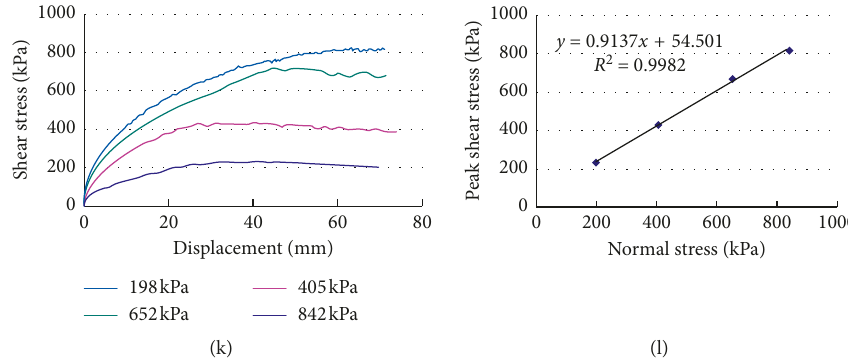
Figure 5: The relationship curve representing test results for sample waste rocks. (a) Shear stress-displacement curve for Pit J1 (natural). (b) Peak shear stress-normal stress curve for Pit J1 (natural). (c) Shear stress-displacement curve for Pit J1 (saturated). (d) Peak shear stress- normal stress curve for Pit J1 (saturated). (e) Shear stress-displacement curve for Pit J2 (natural). (f) Peak shear stress-normal stress curve for Pit J2 (natural). (g) Shear stress-displacement curve for Pit N2 (natural). (h) Peak shear stress-normal stress curve for Pit N2 (natural). (i) Shear stress-displacement curve for Pit N3 (natural). (j) Peak shear stress-normal stress curve for PitN3 (natural). (k) Shear stress-dis- placement curve for Pit N3 (saturated) (l) Peak shear stress-normal stress curve for Pit N3 (saturated). Table 5: Test results of sample waste rock. Sample rocks